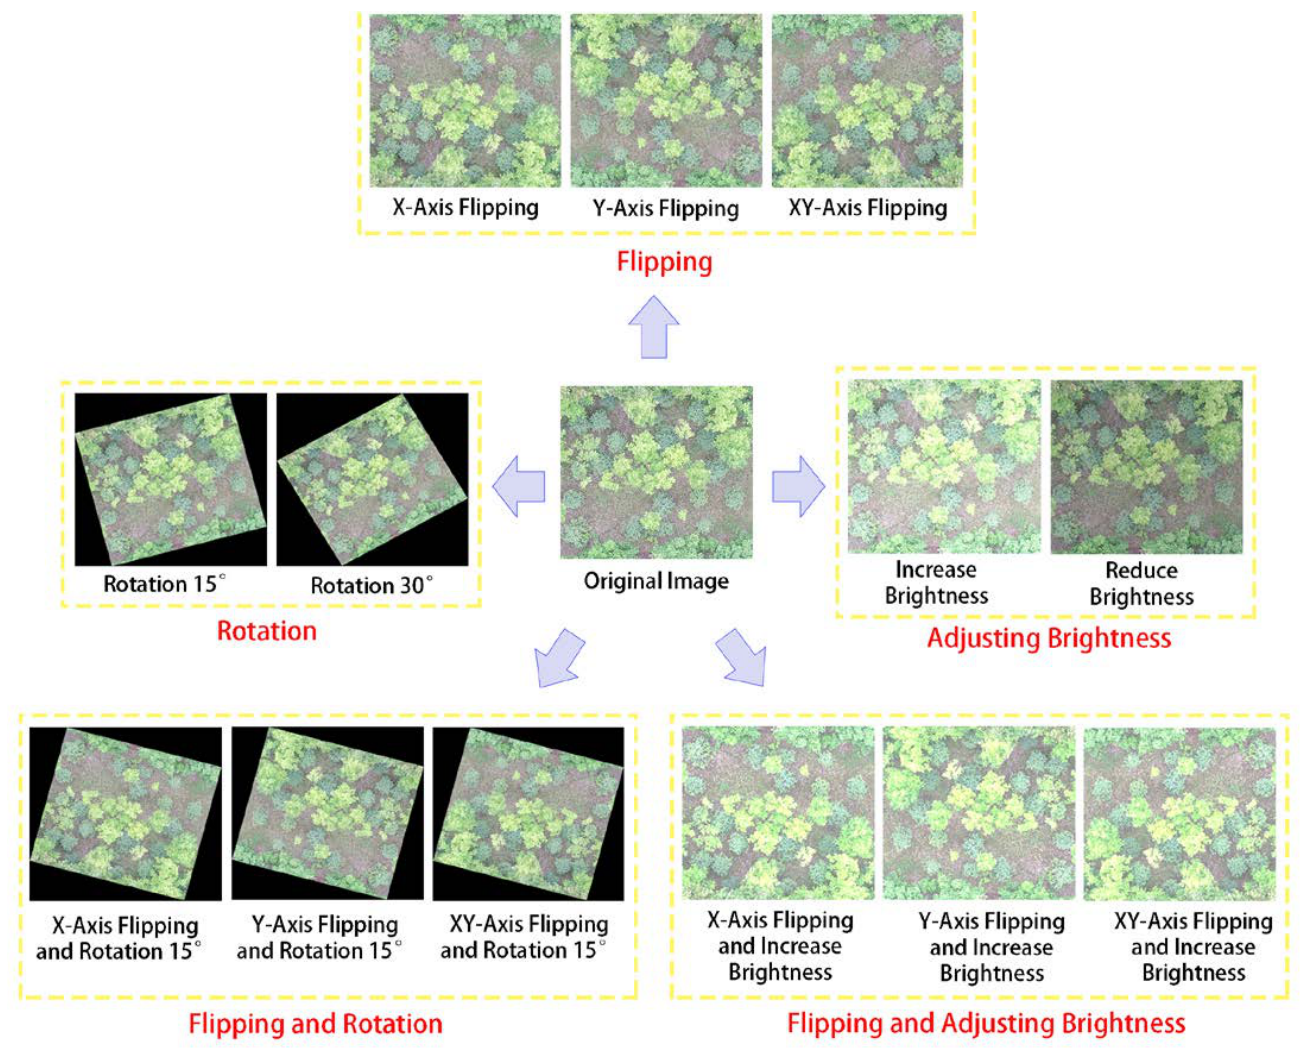
Figure 4. Examples of the data augmentation dataset.